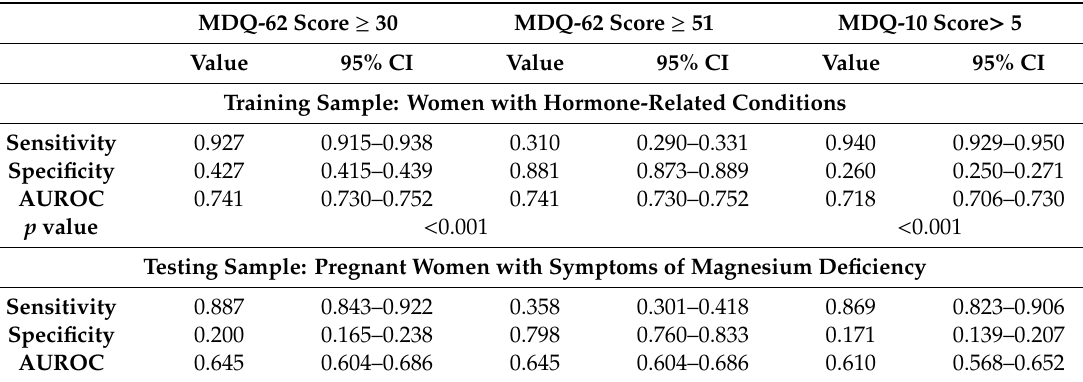
Table 2. Diagnostic performance of MDQ-10 compared with that of MDQ-62 using a serum magnesium level cut-o ff of 0.66 mmol /